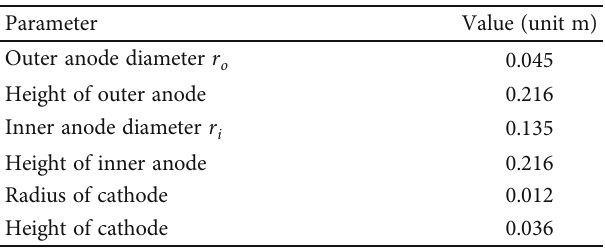
Figure 1: Structure diagram of annular ion thruster. Table 1: The geometric parameters.